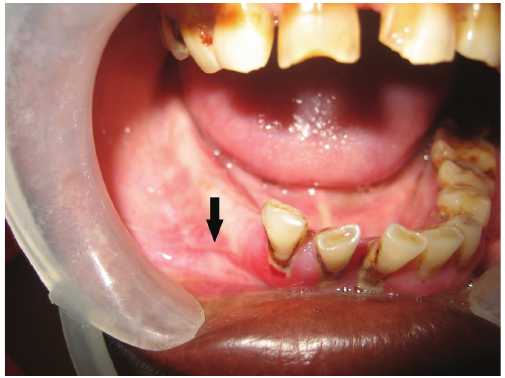
Figure 2: Intraoral radiograph showing the radiopaque foreign body close to the mental foramen.